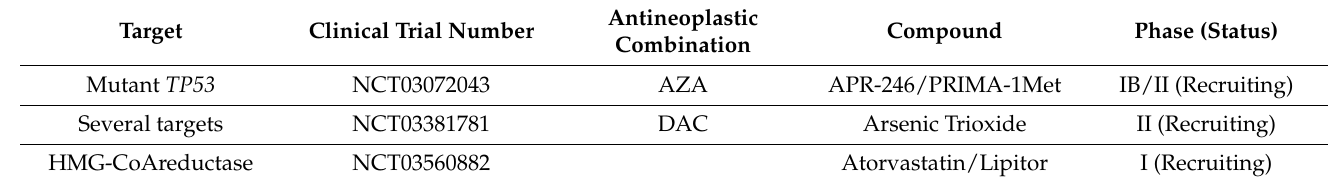
Table 2. Clinical trials to degrade mutant